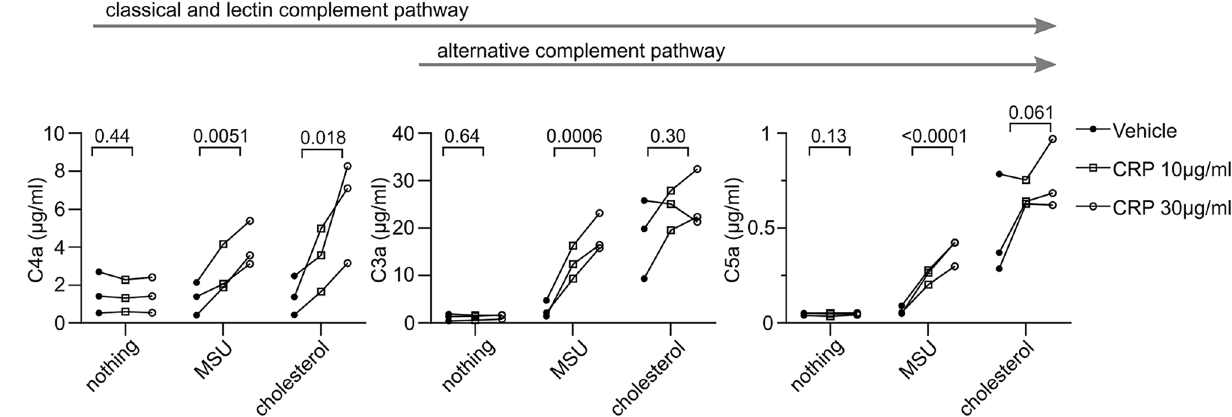
Figure 4. CRP drives anaphylatoxin production in the presence of MSU crystals. IgM/IgA-deficient serum obtained from 3 individuals with CVID was depleted of CRP and then reconstituted with vehicle or CRP at 10 or 30 µg/ml. The serum samples were incubated for 30 min with nothing, MSU lot 2, or cholesterol crystals. The concentrations of anaphylatoxins C4a, C3a, and C5a in the serum after the incubation are shown. p values are shown for the comparison of the means of vehicle, 10 µg/ml CRP, and 30 µg/ml CRP as determined by one-way repeated-measures